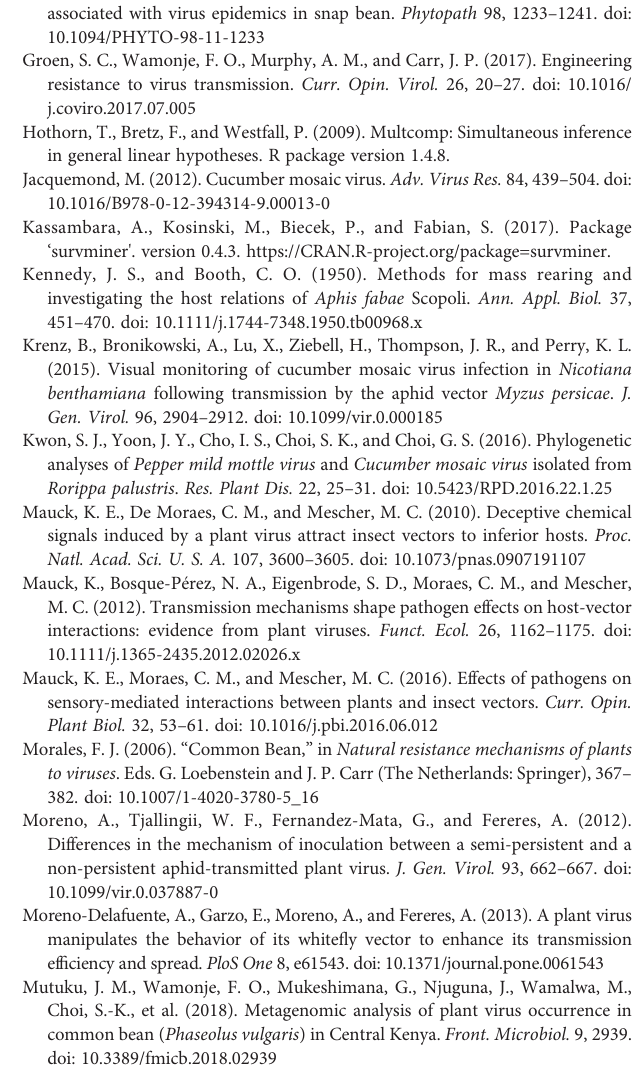
TABLE S1 | Raw EPG data for Aphis fabae feeding behavior for Figure 2 . TABLE S2 | Raw EPG data for Myzus persicae feeding behavior for Figure 2 . TABLE S3 | Survivorship analysis of aphid phloem feeding behavior for Figure 5